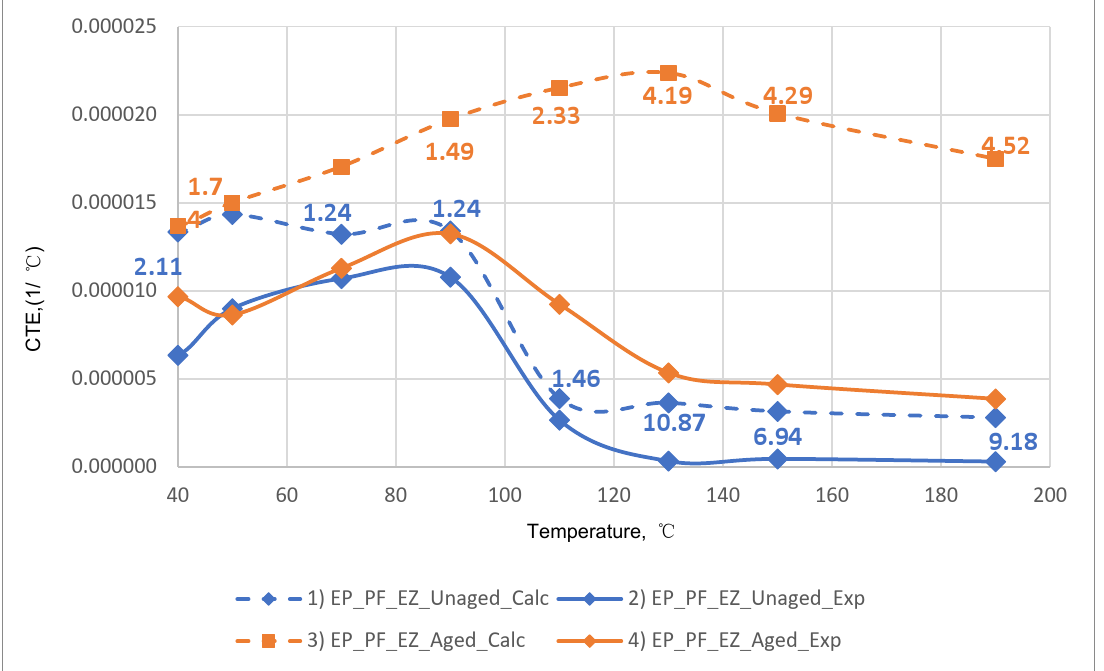
Figure 20. Dependence plotted on the averaged CCTE values on the temperature for epoxy-phenolic fiberglass plastic on glass fabric EZ-200: (1) calculated for EP-PF-EZ200; (2) experimental for EP-PF- EZ200; (3) calculated for EP-PF-EZ200-TA; (4) experimental for EP-PF-EZ200-TA.